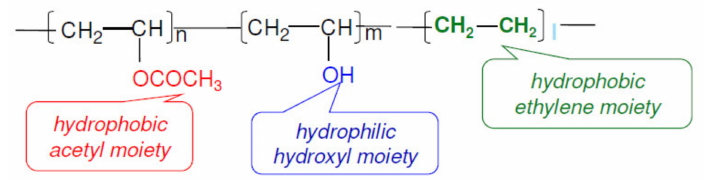
Figure 1. Chemical structure of Exceval™ AQ-4104.